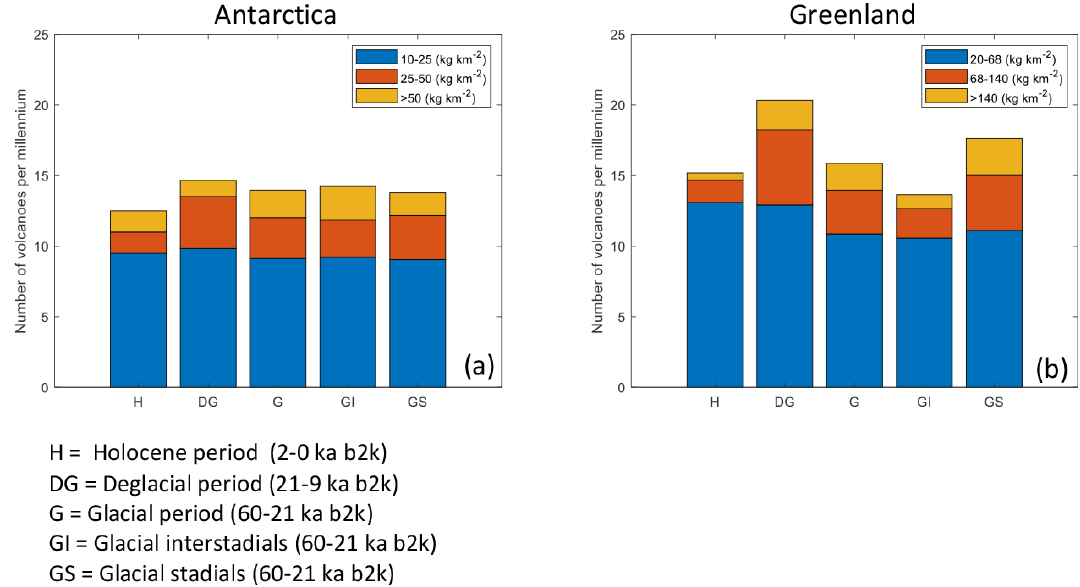
Figure 4. Comparison of the number of volcanic eruptions per millennium detected in (a) Antarctic and (b) Greenland ice cores grouped for different climatic periods with relatively similar data resolution for the last 2500 years and the late glacial period. The applied datasets and smoothing are the same as used for Fig. 3. The detected eruptions are classified into three size fractions similar to the approach in Fig. 3.